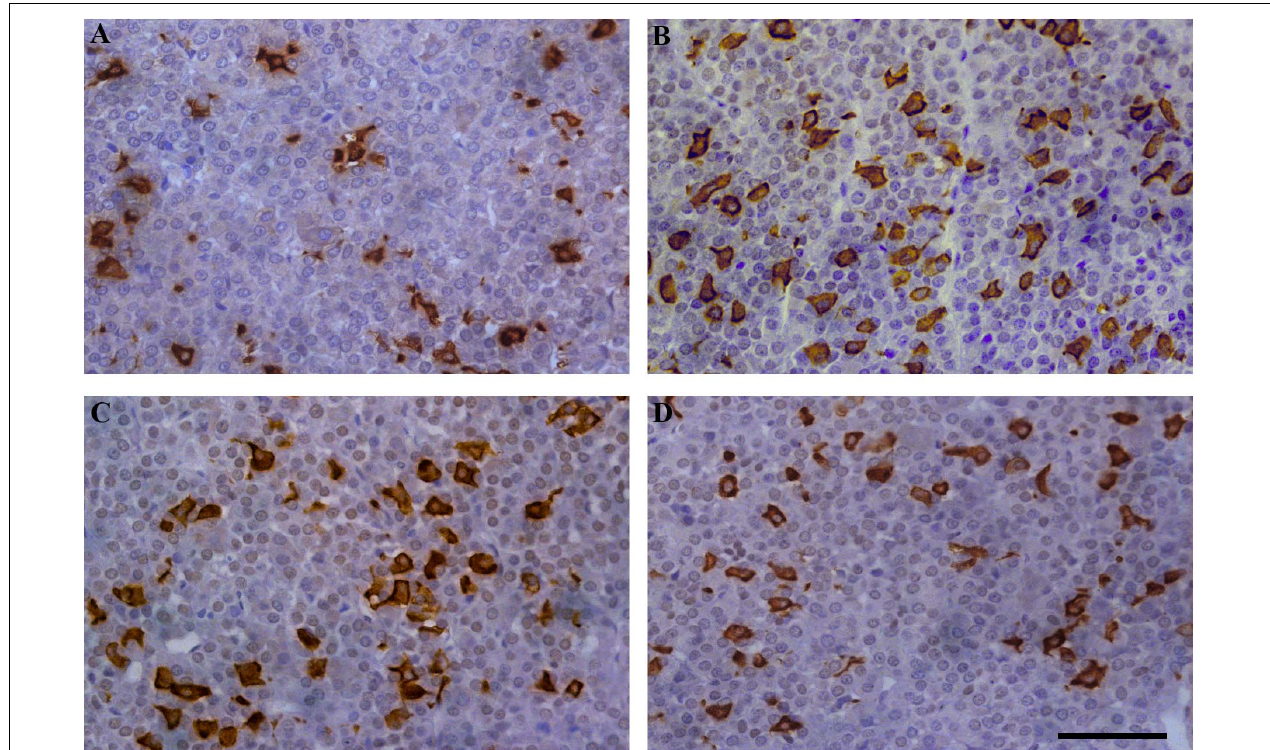
FIGURE 3 | Temporal changes in the immunoreactivity of ACTH cells during EAE. Pituitary glands were obtained from rats afflicted with EAE, (A) control rat, and EAE rats sacrificed at onset (B) , peak (C) , and end of the disease (D) . Scale bar 50 µ